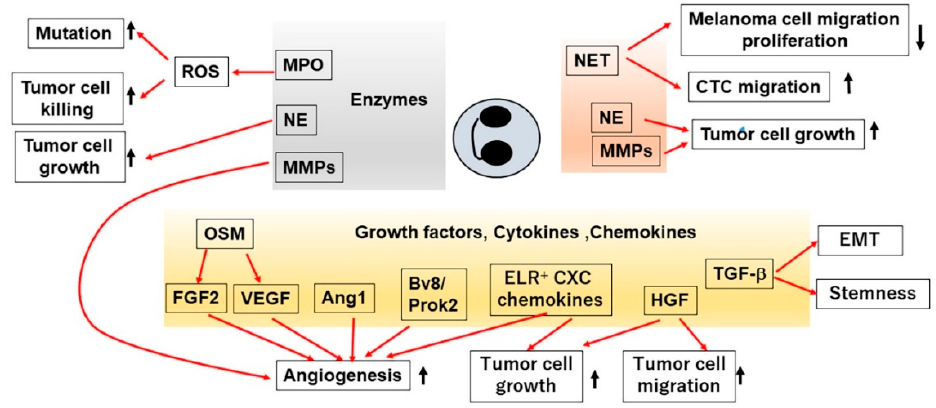
Figure 2. Presumed functions of TANs in tumor development and progression.